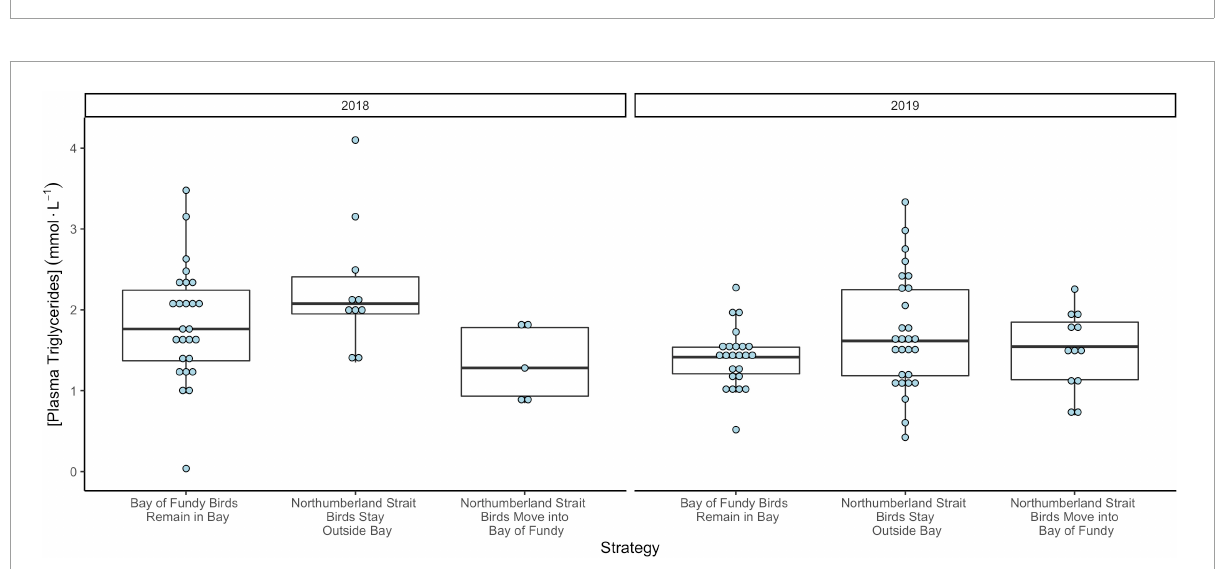
FIGURE5 β -Hydroxybutyrate concentrations (mmol · L − 1 ) of adult (light blue) and juvenile (dark blue) Semipalmated Sandpipers in 2019 (left) and 2020 (right) sampled at Petit Cap. Center line represents the median, with 1 st and 3 rd quartiles shown in boxes. Whiskers show interquartile range, and points show individual measures. Results of statistical comparisons are provided in Table 3